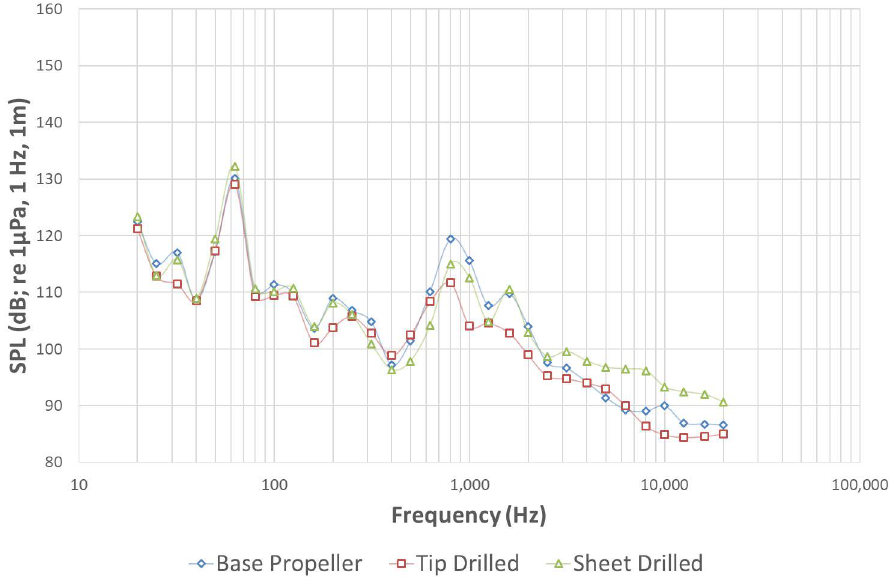
Figure 4. Comparative sound pressure levels of three model propellers J = 0.55 and cavitation condition. Reproduced from [13] with permission from Newcastle University.